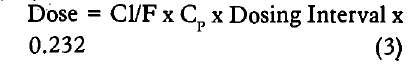
Fig. I: Average serum phenobarbito ne concentrations in dogs for the initial day of dosing